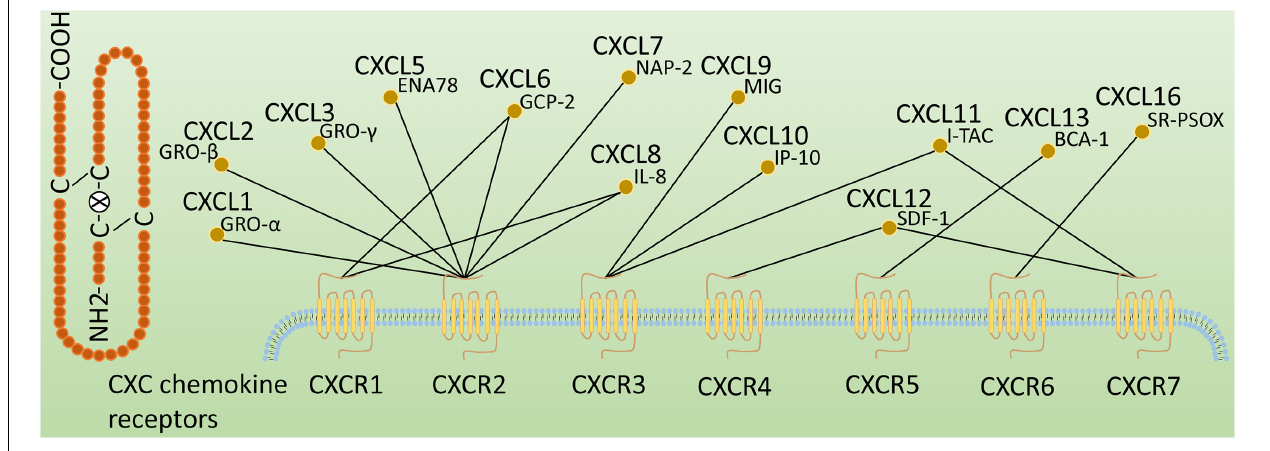
FIGURE 1 | Classification of CXC chemokine receptors. CXC chemokine receptors are classified according to the ligands they bind, followed by an R (representing receptor) and a number corresponding to the order of discovery. These CXC chemokine ligands are also known as GRO- α (CXCL1), GRO- β (CXCL2), GRO- γ (CXCL3), ENA78 (CXCL5), GCP-2 (CXCL6), NAP-2 (CXCL7), IL-8 (CXCL8), MIG (CXCL9), IP-10 (CXCL10), I-TAC(CXCL11), SDF-1(CXCL12), BCA-1(CXCL13), and